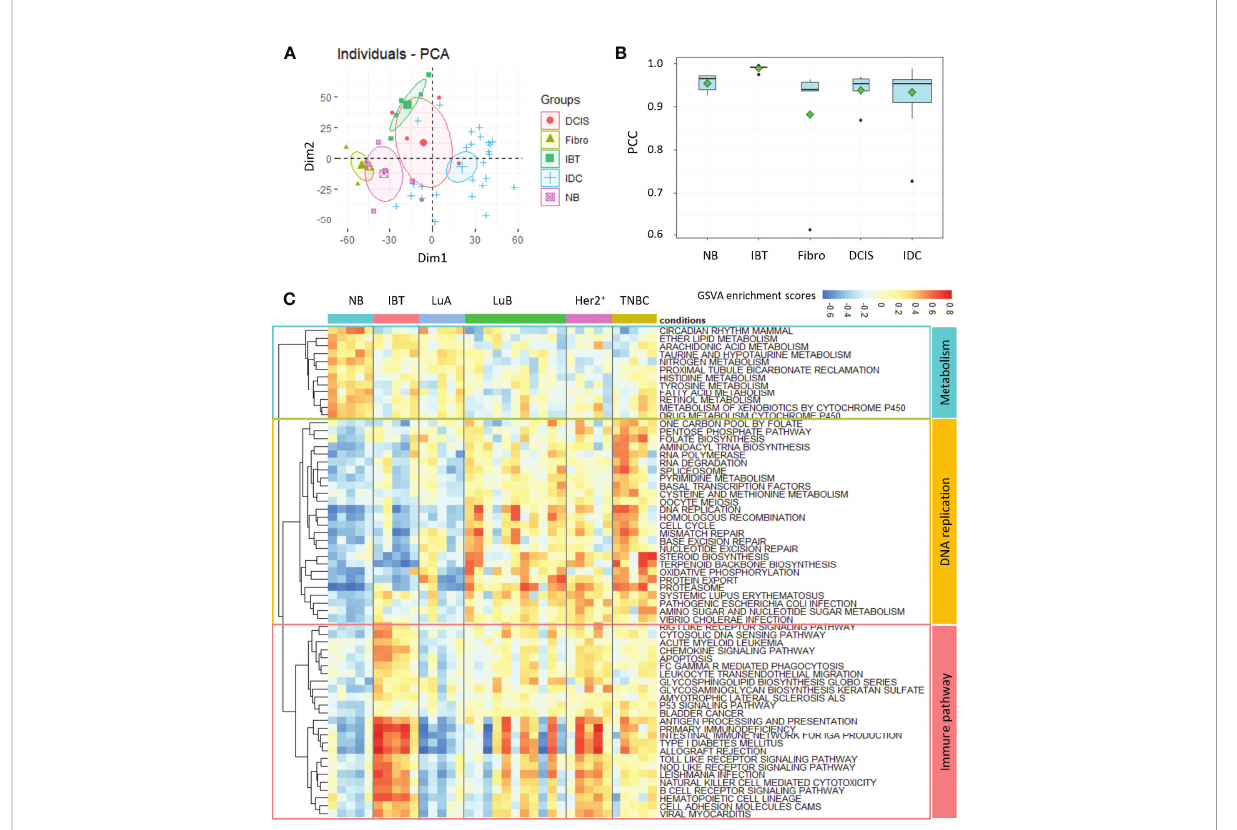
FIGURE 1 In fl ammatory breast tissues and ER − breast tumors shared similar transcriptional pro fi le. (A) PCA analysis of gene expression pro fi le among different breast tissues. NB, normal breast tissue; IBT, in fl ammatory breast tissue; Fibro, fi broadenoma; DCIS, ductal carcinoma in situ ; IDC, invasive ductal carcinoma. (B) The Pearson correlation coef fi cient (PCC) of each sample ’ s transcriptome with the average gene expression pro fi les of all genes in IBT samples. (C) Heatmap of differentially activated KEGG pathways in NB, IBT, and IDC. IDC: Luminal A (LuA), Luminal B (LuB), Her2 + , and